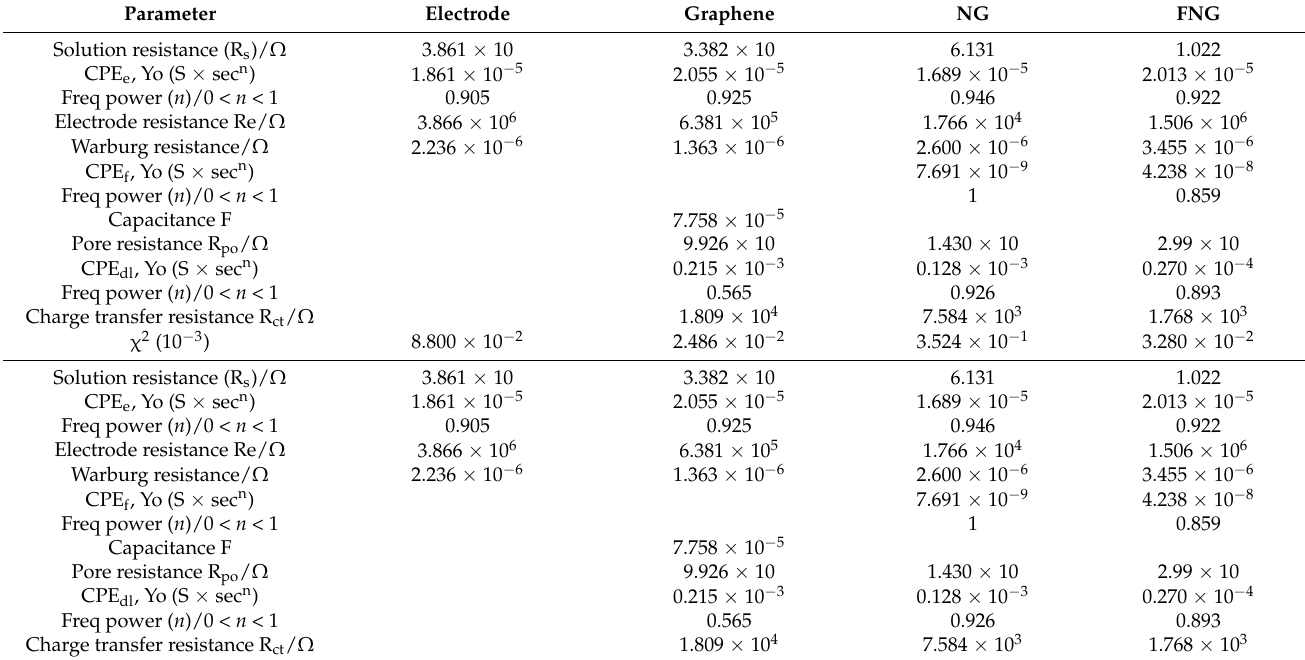
Table 1. Experimental parameters of EIS